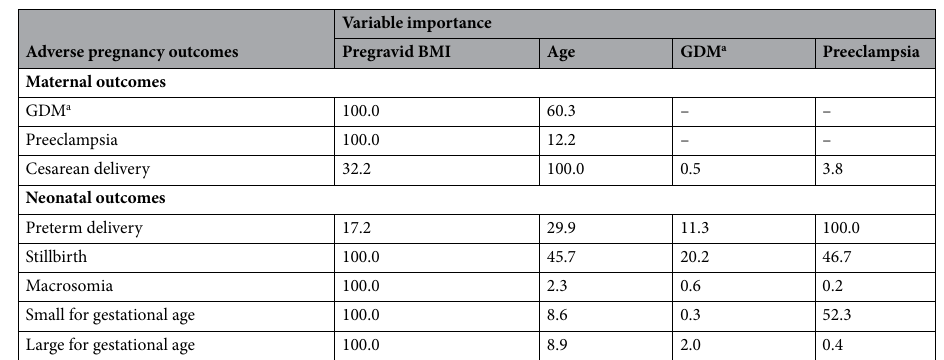
Figure 2 displays risks of pre-pregnancy underweight, overweight, or obesity on infant outcomes, stratified by maternal age. With higher maternal age, there is a slightly decreased trend in the risk of higher pre-pregnancy BMI on preterm delivery, and its odds ratio reached a low point at the maternal age of 30–35. Meanwhile, cat- egorized as underweight based on pre-pregnancy BMI is also a risk factor for preterm delivery in the highest maternal age category. Across all maternal age categories, there are positive associations between increasing pre- gestational BMI and macrosomia and LGA. Negative associations were observed between pre-gestational BMI and SGA in infants whose mother’s age was over 25. Children with pre-pregnancy overweight or obese mothers were at higher risk of stillbirth in the same maternal age categories. As shown in Table 4, pregravid BMI indicates more influence on GDM, preeclampsia, stillbirth, macrosomia, SGA and LGA, while maternal age is more relevant on cesarean delivery. After further examination as explana- tory variable, preeclampsia has the most significant influence on preterm delivery compared to pre-pregnancy BMI, maternal age and GDM.